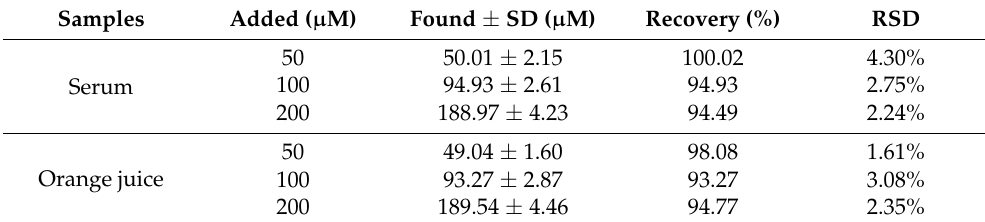
Table 2. The Glu sensing in human serum and orange juice by